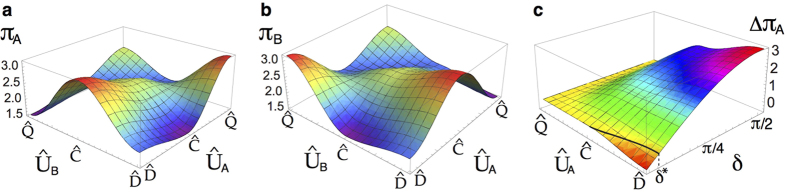
Players payoffs and Nash inequality for the quantum PD game.(a) Alice and (b) Bob’s payoff functions for the initial mixed-separable-discorded state ρin(p = 1/3) as function of the strategy space; , with , is the quantum strategy that removes the dilemma. (c) The left-hand-side value in equation (5), ΔπA, is plotted as a function of the players strategies and the measurement parameter δ. The Nash inequality takes positive values almost anywhere the surface, except at the red region below the black curve; e.g., for the particular strategy , the inequality is not satisfied for δ < δ* = arcsin(1/7). Since p is just a global factor in equation (5), this behaviour holds even for input states with zero entanglement.